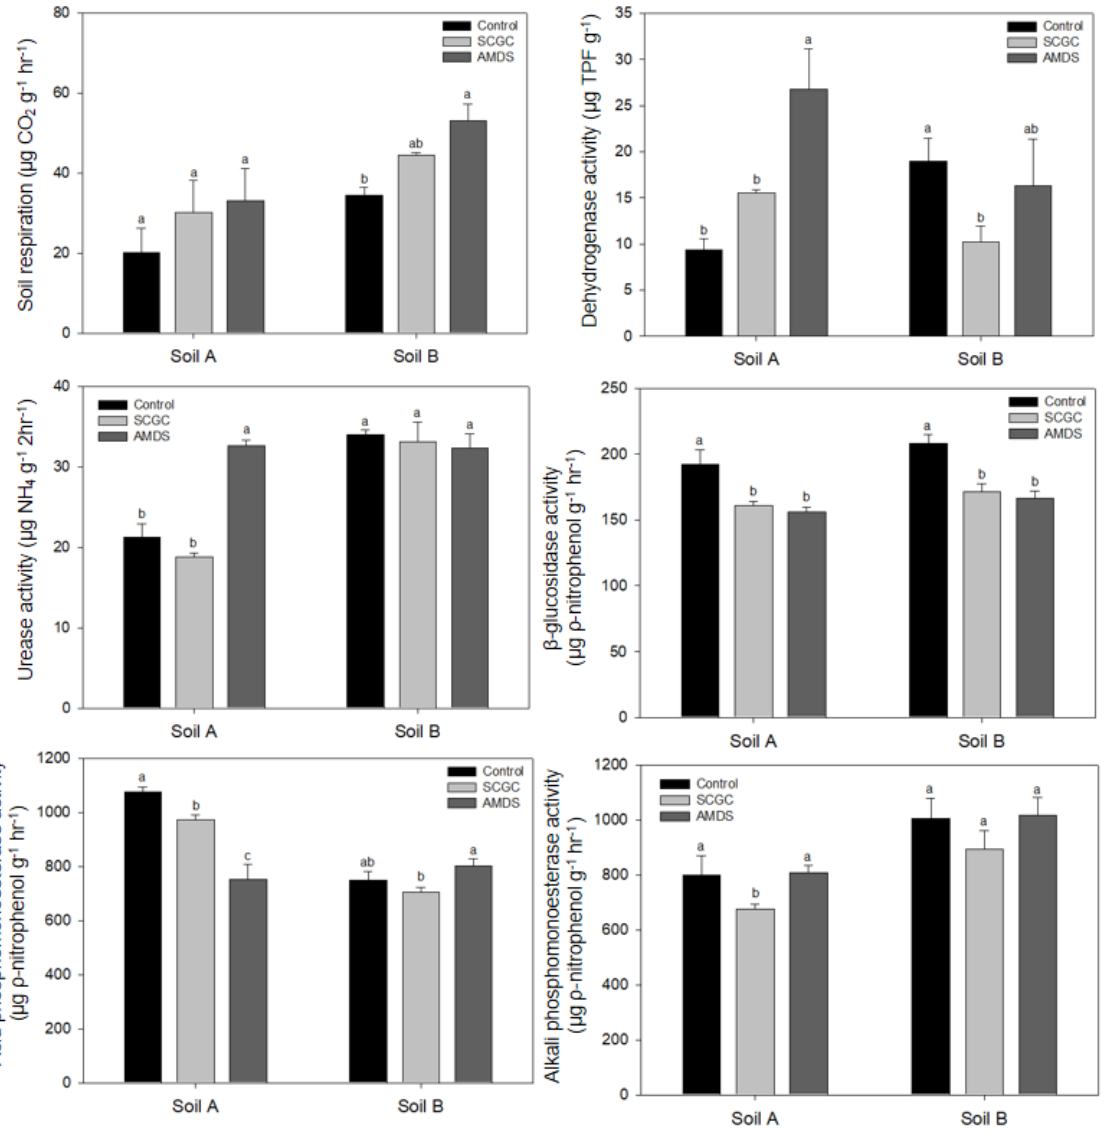
Figure 2. Effect of amendments on soil biological properties. Different letters indicate the significant differences at the 5% level according to Tukey’s test.